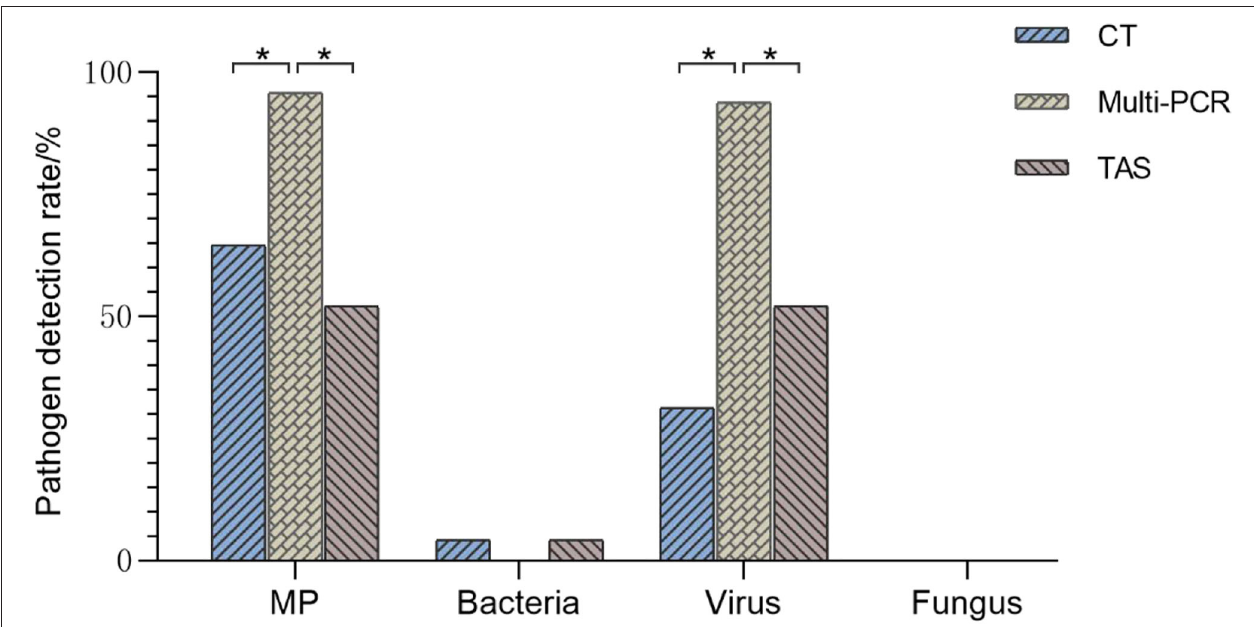
FIGURE 4 | Comparison of pathogens detection results of three methods (TAS pathogen detection based on CT or Muti-PCR. * p < 0.01).